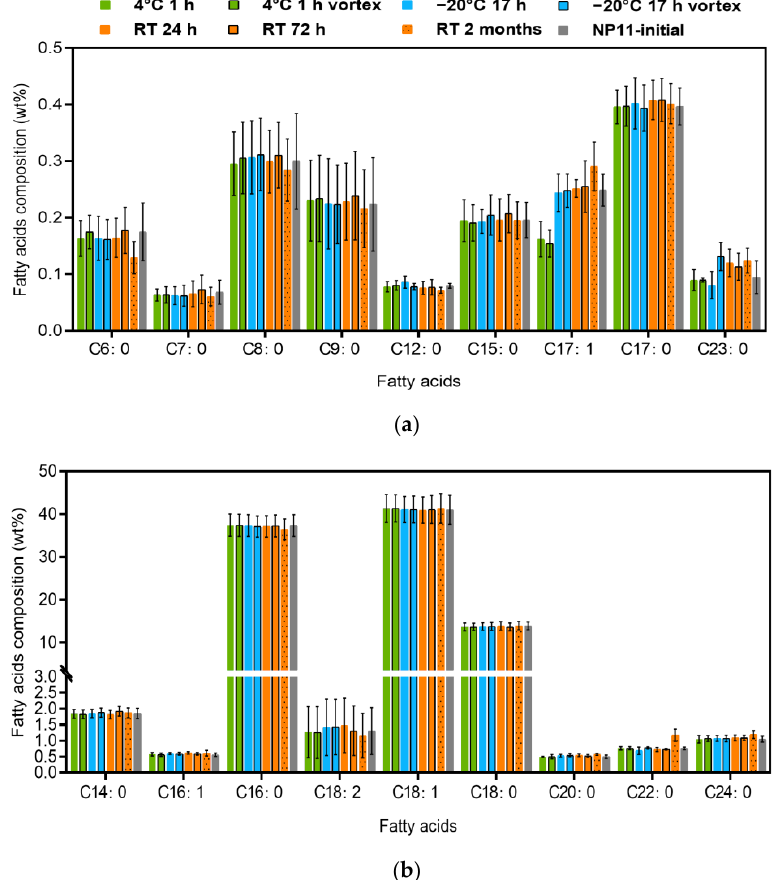
Figure 4. Effect of storage conditions on fatty acid compositions of lipids produced by R. toruloides NP11 . ( a ) Profiles of the trace fatty acids. ( b ) Profiles of the main fatty acids. The green column for samples being held at 4 °C for 1 h and those with a black line box for samples with vortex treatment; the blue column for samples being kept at − 20 °C for 17 h and those with a black line box for samples with vortex treatment; the orange for samples being stored at RT for 24 h, the orange with a black line box for samples being held at RT for 72 h, and those with black point background for samples being held at RT for 2 months; the grey column for as-prepared samples without storage. RT, room temperature (25 ± 1 °C). All data are presented as a mean ± SD of biological triplicates. p -value of two- tailed Student’s t -test and FDR were shown in Table S3. 4. Discussion Many studies demonstrated R. toruloides as a promising platform for lipid production owing to its diverse substrate appetites, robust stress resistance, and other favorable fea- tures. In recent years, significant progress has been made in genome sequencing [12,13], multi-omics analysis [14], and genome-scale modeling [28]. Moreover, several molecular and genetic tools for engineering R. toruloides were previously developed, including gene transformation [29,30], and an RNA interference method as well as a CRISPR Cas9 ge- nome editing system [23,31]. Meanwhile, the development of genetic components (pro- moters, markers, terminators, etc.) and transformation methods have paved the way to- wards refined genomic and metabolic engineering regulation. In addition, it is necessary to understand the endogenous metabolic pathways and related metabolites. There have been numerous basic studies on lipid synthesis and fatty acid metabolisms, such as lipid droplets and fatty acid synthases (FASs) of R. toruloides